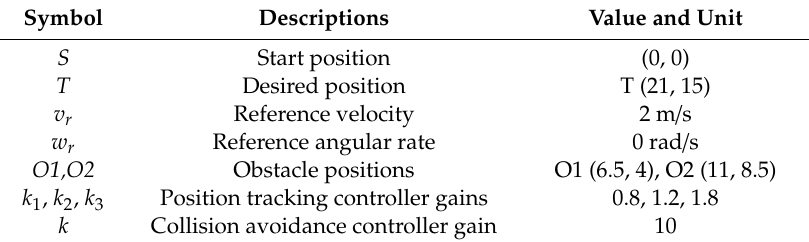
Table 2. Parameters of the first example simulation.